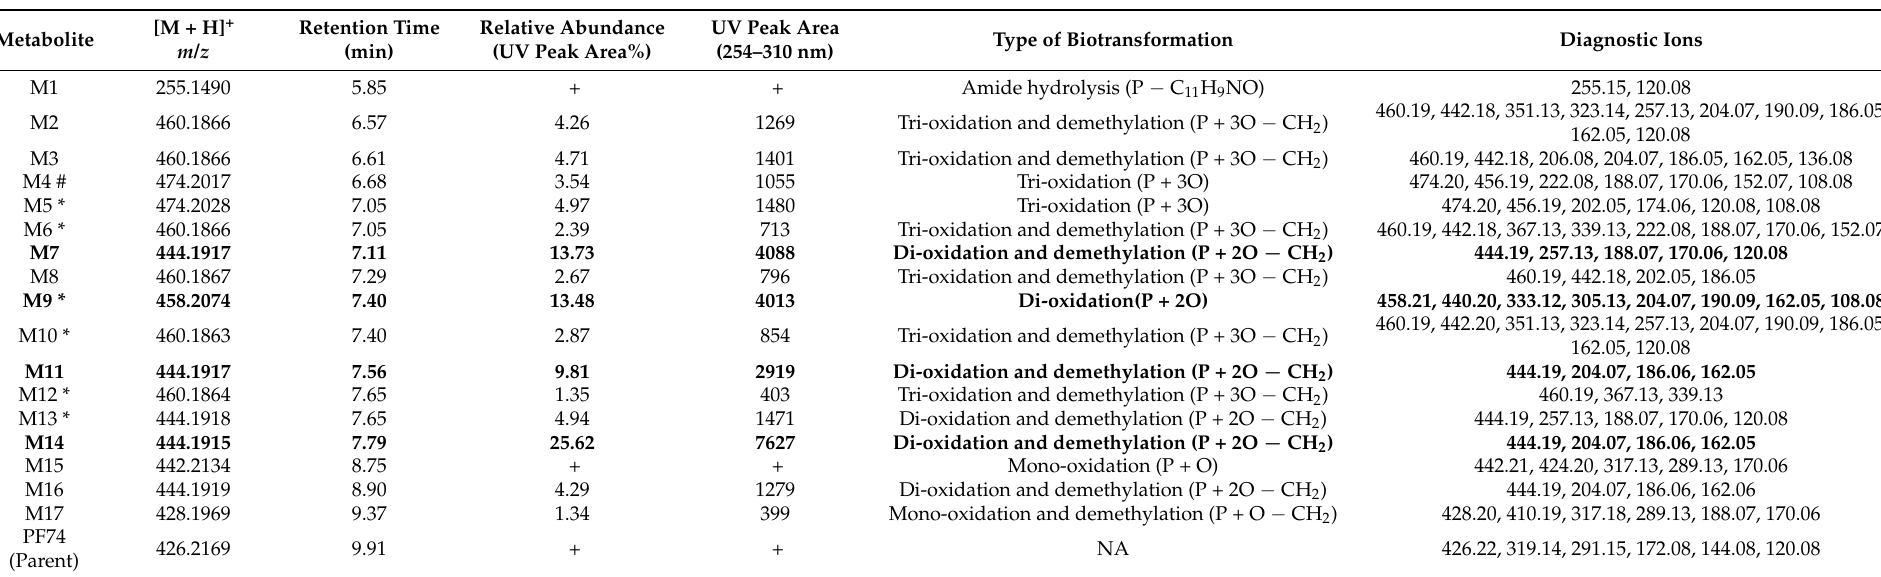
Table 1. List of putative metabolites of PF74 with the primary identification parameters and hypothesized biotransformation. The relatively most intense metabolites are in bold.